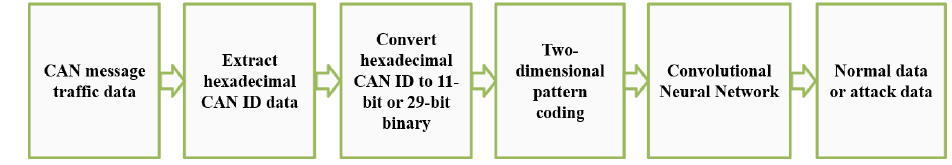
Figure 8. The flowchart of the overall scheme.